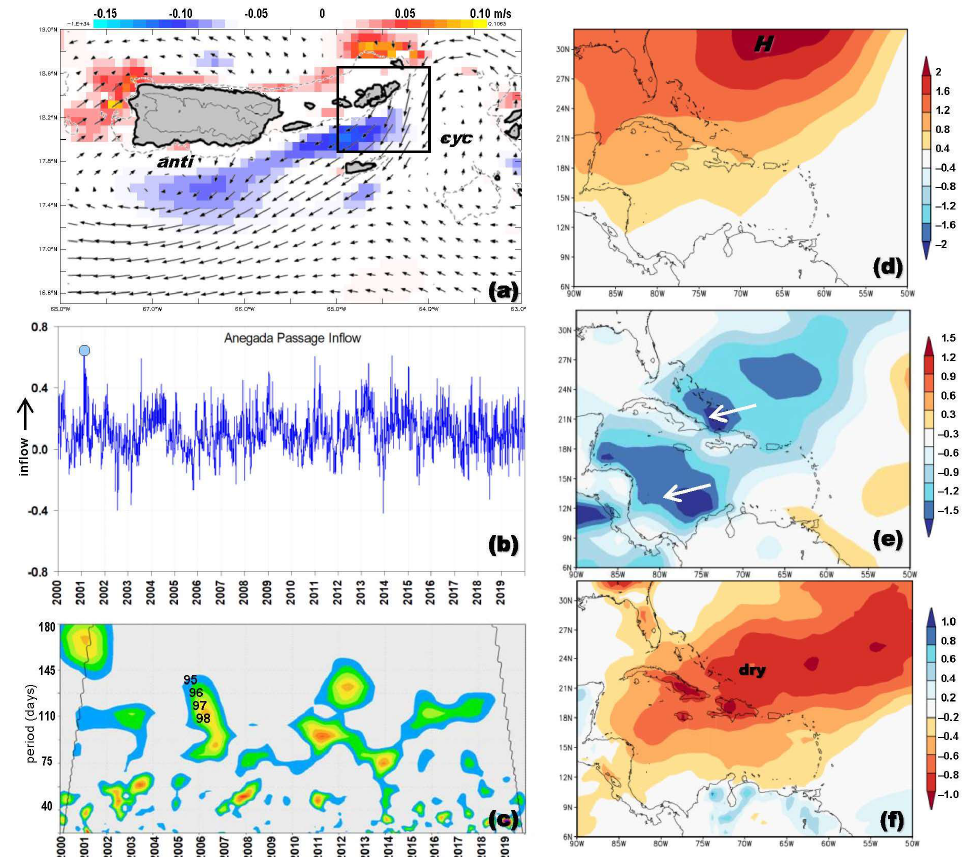
Figure 4. ( a ) Mean 100 m current vectors and U component (shaded) around the Anegada Passage with standing eddies labelled. ( b ) Time series of daily Anegada inflow (box in a ) and its ( c ) wavelet spectral energy shaded from 95% to 99% confidence. Right column: regression of daily Anegada inflow time series onto field anomalies of: ( d ) ERA5 SLP, ( e ) surface zonal wind, ( f ) ERA5 dewpoint Temp, N = 7300. Dot on time series ( b ) is case analyzed in Figure 6. Insignificant field values are neutral